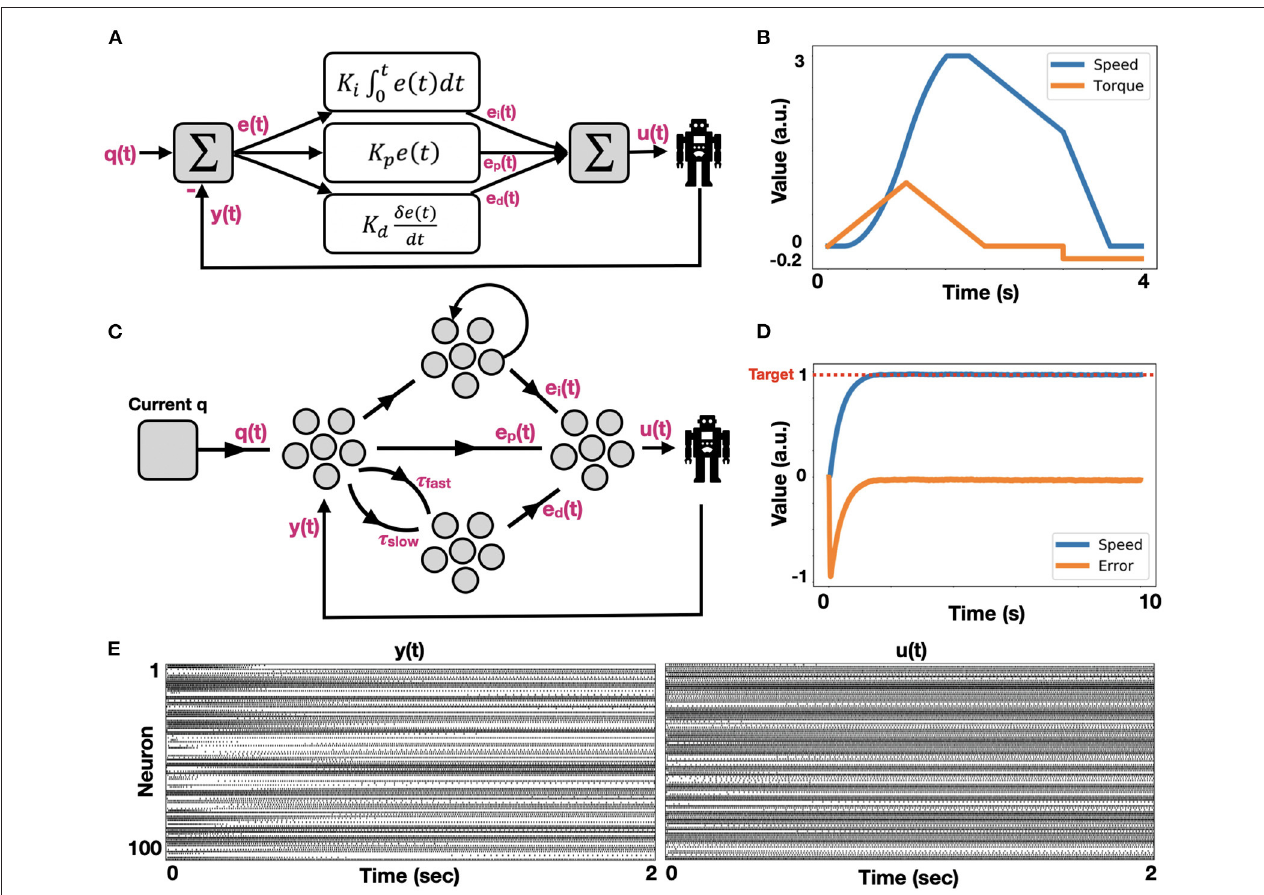
FIGURE 3 | Neuromorphic implementation of PID control. (A) The canonical schematic of a PID controller, comprising of integrated [ e i ( t )], proportional [ e p ( t )], and differential [ e d ( t )] error terms; (B) Engine actuation model, which is used by our PID controller to induce motion. The engine is induced by a current (blue), generating rotational speed (orange) in a non-linear fashion, as it is taking into account both static and dynamic gear’s friction; (C) Schematic of a neuromorphic PID controller; (D) Neuromorphic PID controller in action. The engine is actuated such that its position is approaching the target while reducing the error; (E) Raster plots of ensembles y ( t ) (feedback) and u ( t ) (robotic